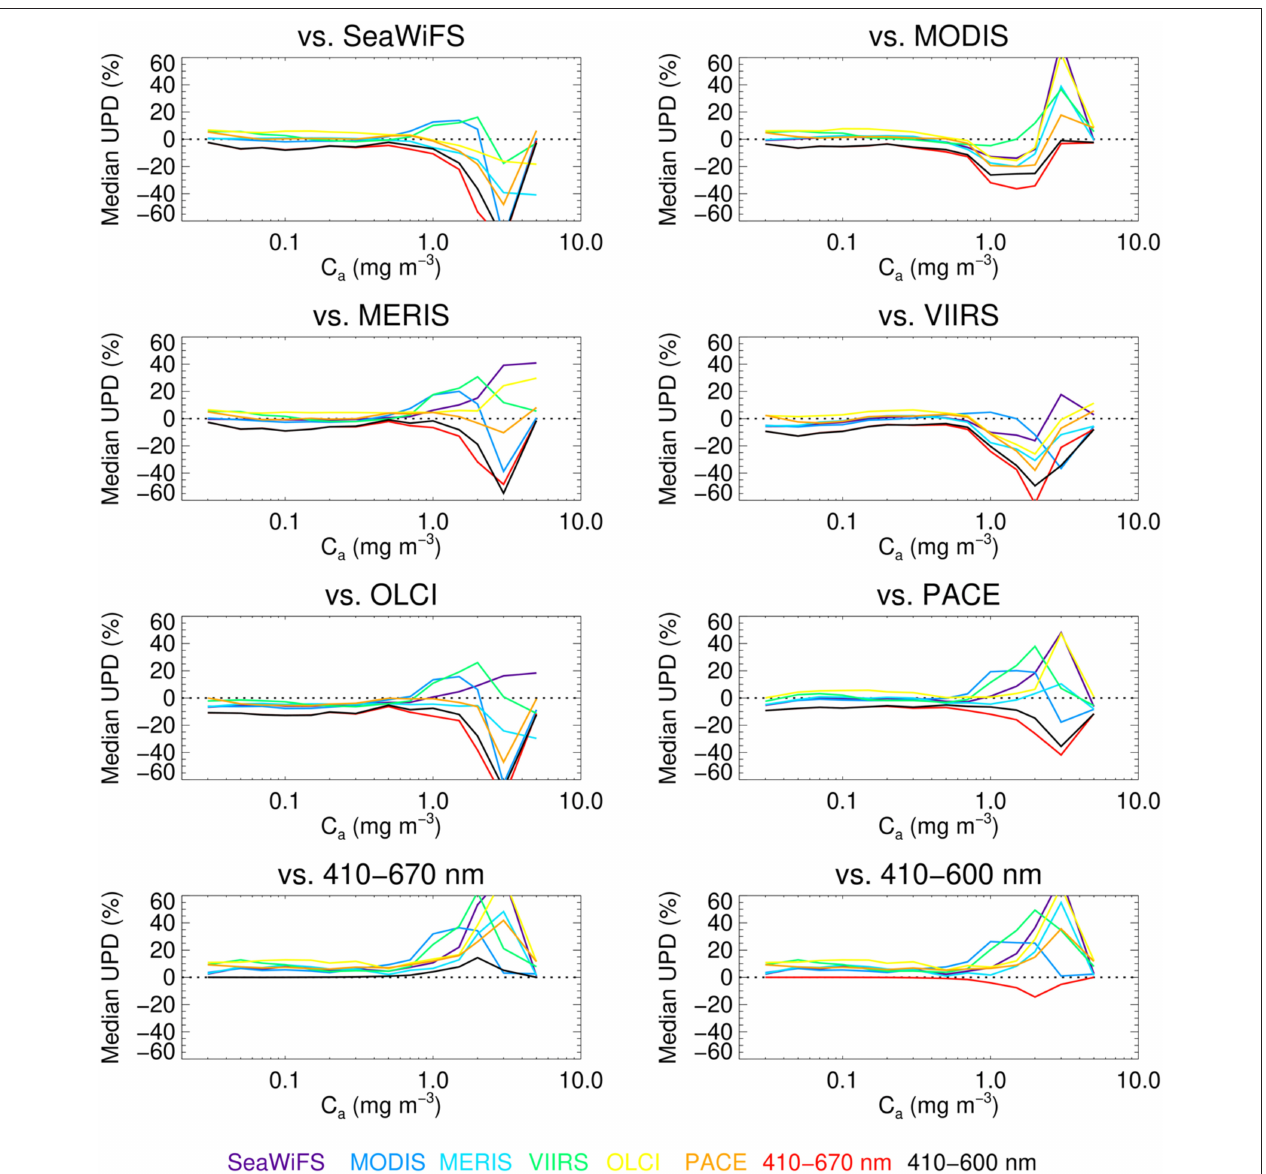
FIGURE 11 | As for Figure 9 , but for a ph